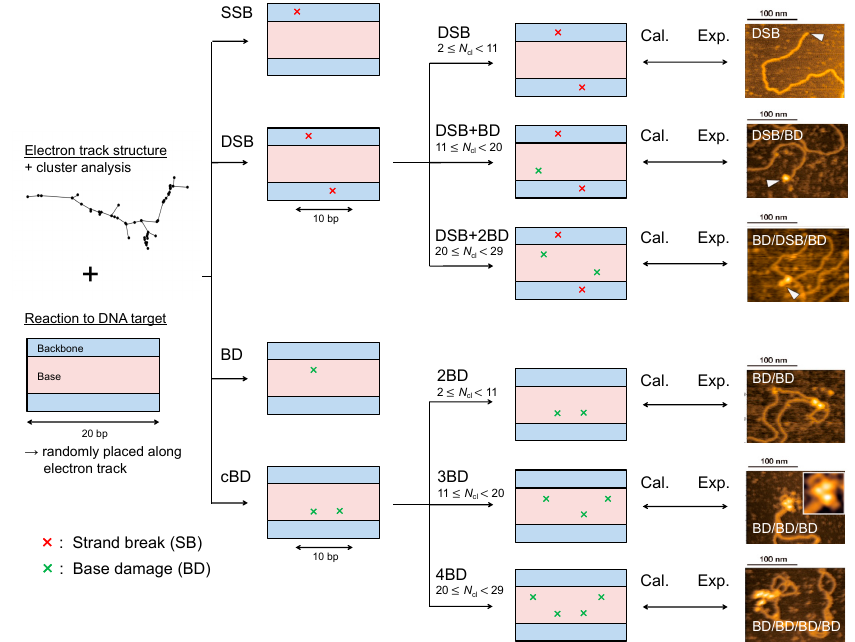
Figure 5. Identification of DNA damage type in the present simulation. The illustration on the left represents an electron track structure and a DNA cylinder. Considering the distance between two ionization and electronic excitation events, we identified single-strand break (SSB), double-strand break (DSB), base damage (BD), complex BD (cBD). The complexities of DSB and cBD then were determined from the number of events per cluster, N cl , at the complex damage site (DSB and cBD). After estimating the yield of each DNA damage type, we compared the estimated results with experimental data [37,38,41] (right images are example pictures obtained with AFM [41]).